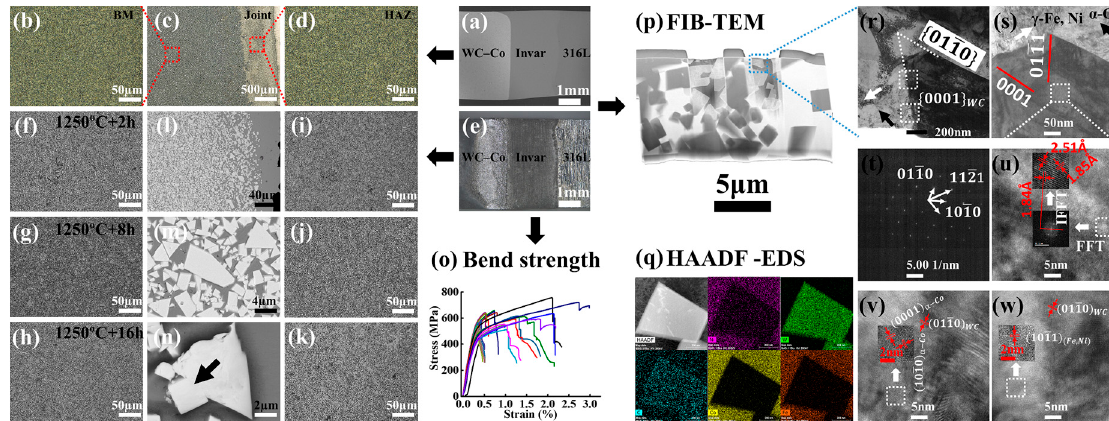
Figure 7. Fiber laser welding of cemented carbide and steel using Invar filler metals. ( a ) As-welded joint (cross-sectional view) composed of WC–Co (left side), 316L stainless steel (right side), and an Invar interlayer (middle). Higher-magnification images of ( b ) base material, ( c ) joint, and ( d ) HAZ; ( e ) as-annealed joints of WC–Co (left side) and 316 L stainless steel (right side) with an Invar interlayer (middle) held at 1250 ◦ C; base materials held at 1250 ◦ C for ( f ) 2 h, ( g ) 8 h, and ( h ) 16 h; and HAZ held at 1250 ◦ C for ( i ) 2 h, ( j ) 8 h, and ( k ) 16 h; and ( l – n ) carbide grain growth after annealing. ( o ) Bend strength. ( p ) FIB–TEM image, ( q ) HAADF–EDS images, and ( r – w ) bright–field TEM and high-resolution TEM images showing structure and crystal lattice. Adapted from [72,73], with permission from Elsevier, 2018.